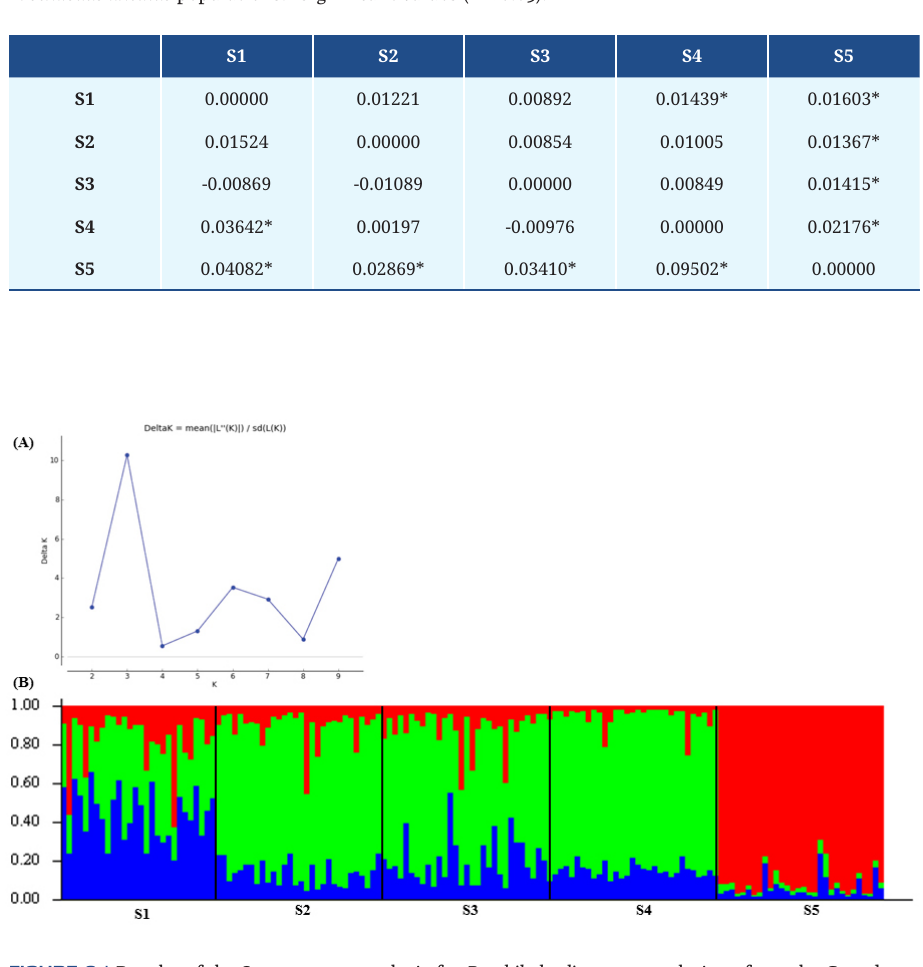
FIGURE 2 | Results of the Structure 2.2 analysis for Prochilodus lineatus populations from the Grande River basin. A. Estimated Delta K (= mean (|L”( K )|)/sd(L( K ))) versus the number of populations, K . Each point is the mean of five independent runs of 10000 Markov chain Montecarlo generations and 1000 generations of ‘burn-in’. B. Barplot showing posterior probability of membership of P. lineatus in the three clusters identified by Structure. Each individual is represented by a single vertical bar in which the color indicates the individual’s estimated membership to alternative clusters. Black vertical lines separate the five sites, and the name of each locality of origin is indicated below. Cluster A in blue; Cluster B in green, Cluster C in red. See the names of the sampling sites in Fig.